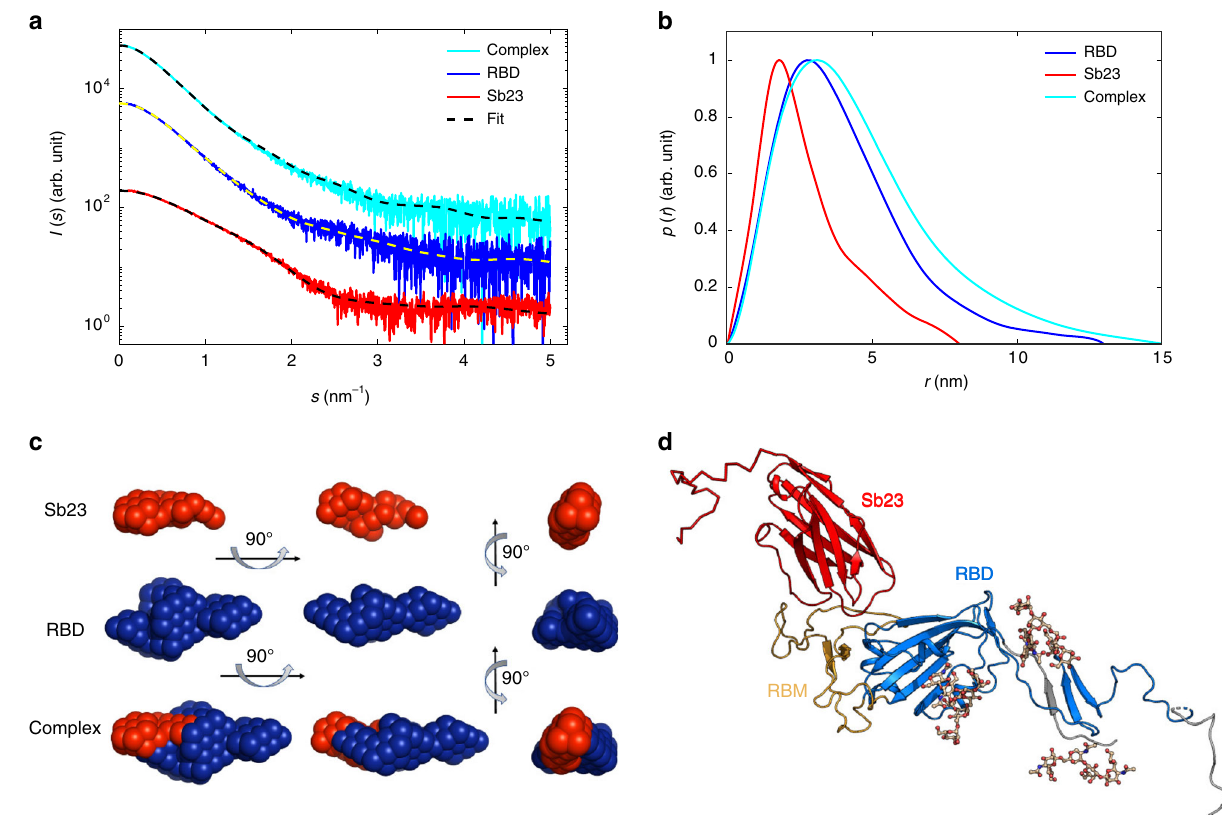
Fig. 4 SAXS analysis of the Sb23 – RBD complexes. a Experimental SAXS data from Sb23, RBD, and its complex. b Distance distribution functions of Sb23, RBD, and their complex. c Two-phase MONSA shape of Sb23 (red beads) and RBD (blue beads). d Hybrid model of Sb23 in complex with